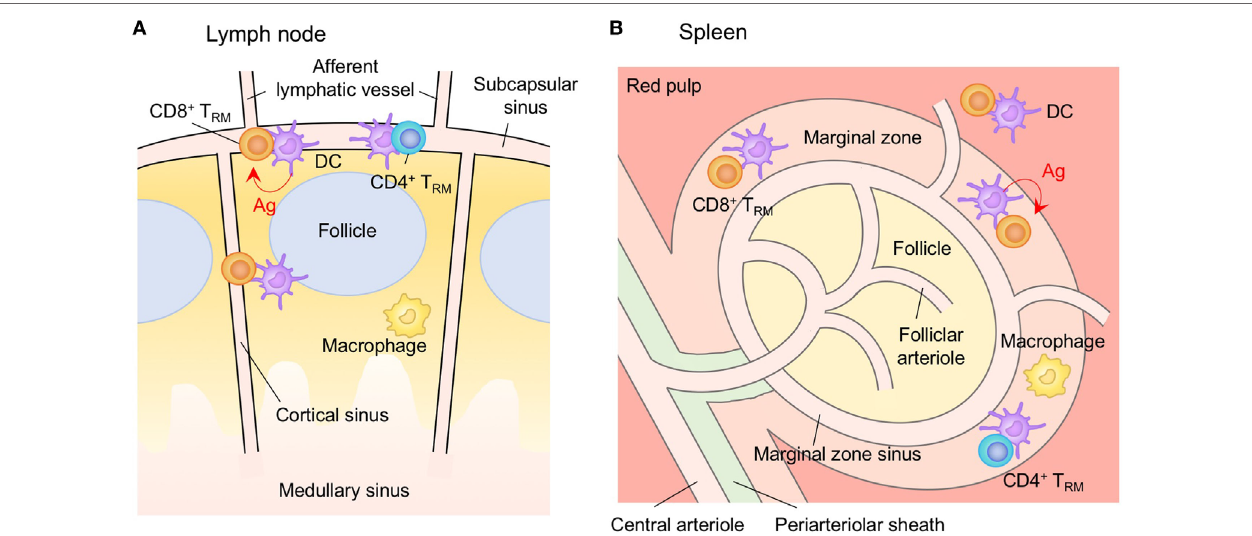
FiGURe 8 | T RM niches in the in the secondary lymphoid organs (SLOs). Both CD4 + and CD8 + T RM cells in the SLO are found at the common antigen entry sites, such as the subcapsular sinus in the lymph nodes (A) , and the marginal zone and red pulp in the spleen (B) . Retention of cells in these compartment is largely dependent on the expression of CD69 in response to antigen, although retention induced by CD69-independent mechanisms is also suspected. Orange cells indicate CD8 + T RM cells unless otherwise stated. Red lines indicate the representative niche factors that influence the maintenance of T RM cells. Abbreviations: Ag, antigen; T RM , tissue-resident memory T